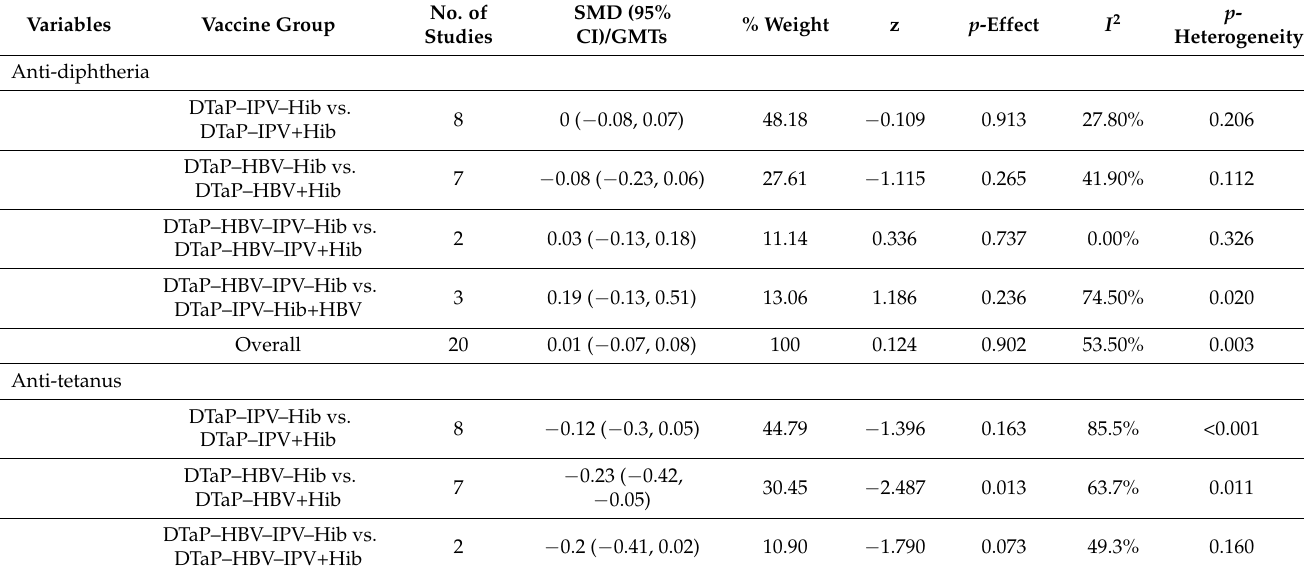
Table 2. The meta-analysis of immunogenicity of different types of combined